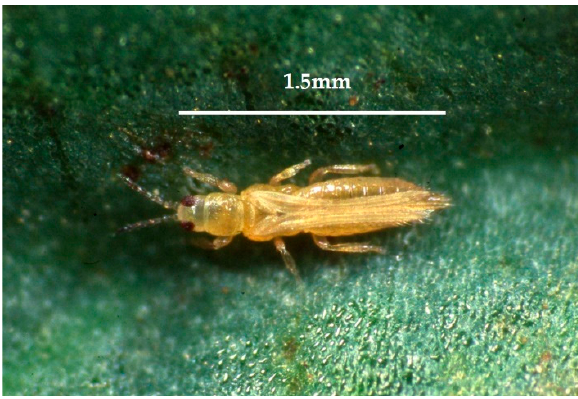
Figure 1. Adult of the onion thrips Thrips tabaci (Photo by R. Antonelli). Among the T. tabaci biological control agents, some predators, such as predatory mites ( Neoseiulus spp.) and Hemiptera ( Orius spp.), have been reported [16]. However, the efficacy of these predators is not considered decisive [6]. Among the T. tabaci predators, Aeolothrips intermedius Bagnall, 1934 (Thysanoptera: Aeolothripidae), is a cosmopolitan species [17,18], also known as “banded thrips” (Figure 2), even if all the congeneric species present the same characteristic of black and white banded wings. Both adults and larvae are floricolous (mainly found in Leguminosae, Rosaceae, and Poaceae; Table 1) and while adults feed mainly on flowers and pollen by their stem-sucking-rasping mouthparts, A. intermedius larvae prey on more than 44 species of Thysanoptera [19].